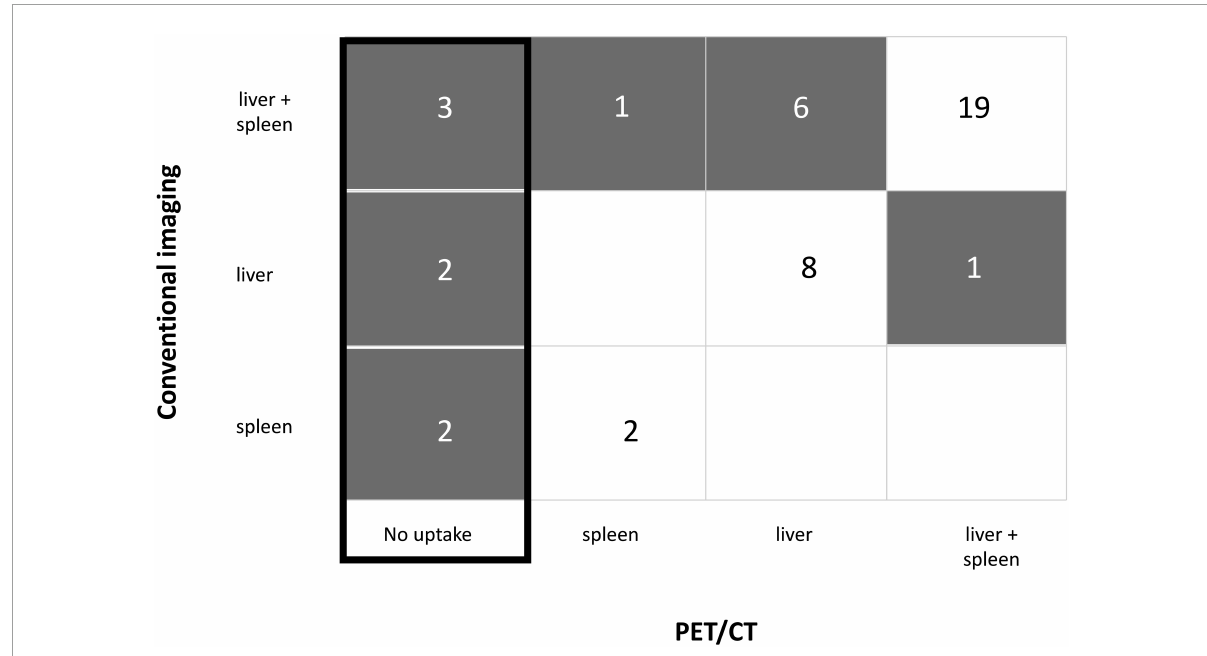
FIGURE1 Discrepancies between baseline positron-emission tomography computed tomography (PET/CT) and conventional imaging regarding lesion localization. The number of patients is represented in each box. Gray color flags a discrepancy between PET/CT and conventional imaging.